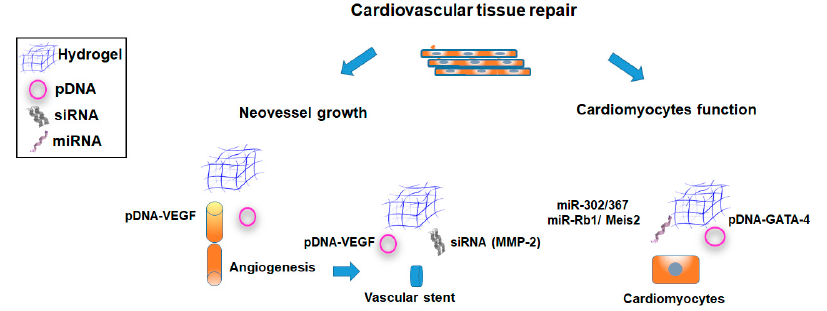
Figure 4. Main strategies involving the use of hydrogel-based nonviral gene delivery systems for cardiovascular tissue repair .